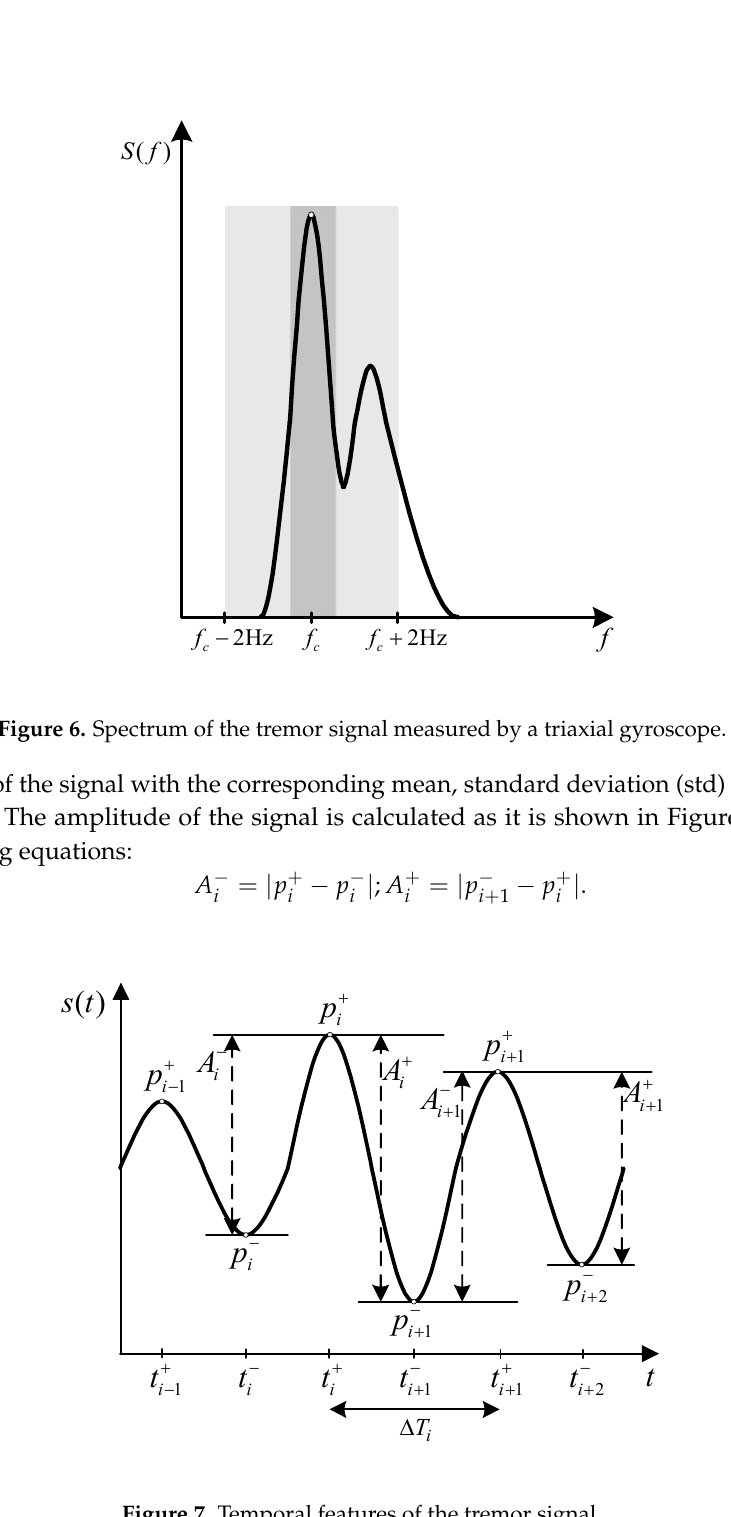
Figure 7. Temporal features of the tremor